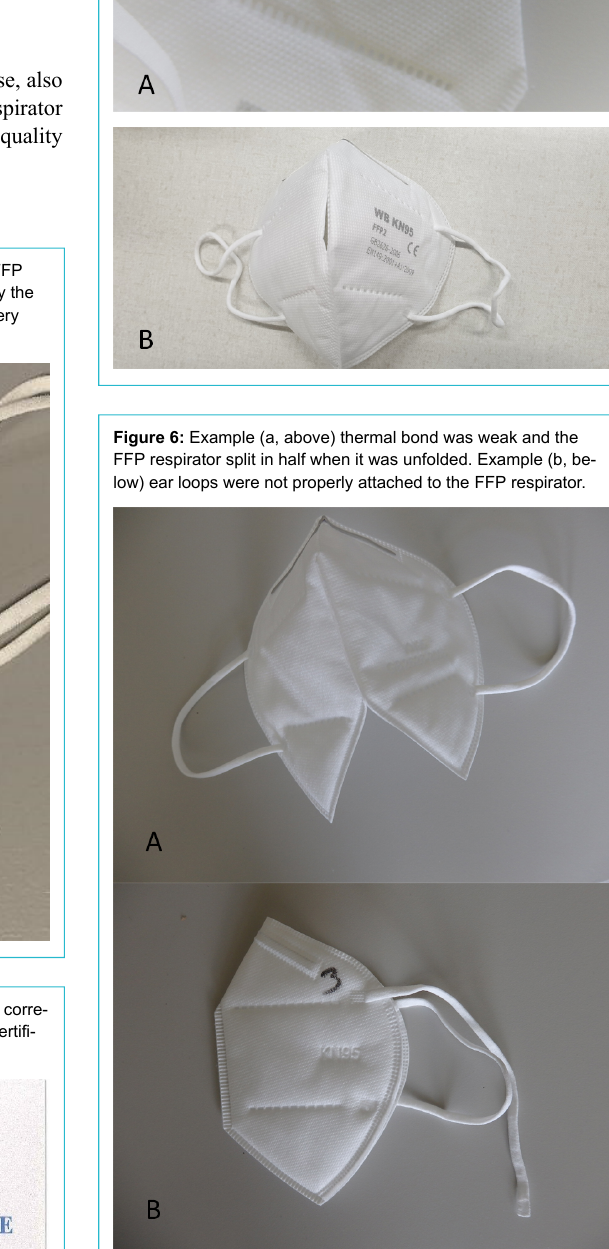
Figure 4: Example of notified body identification number not corre- sponding to the laboratory identified by the logo (Universal certifi- cation has the number 2163 and not 2468)